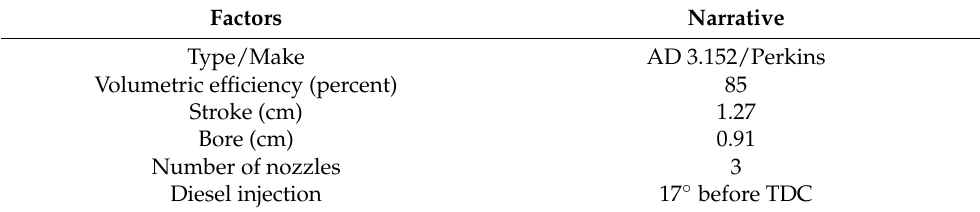
Table 1. Test engine specifications.